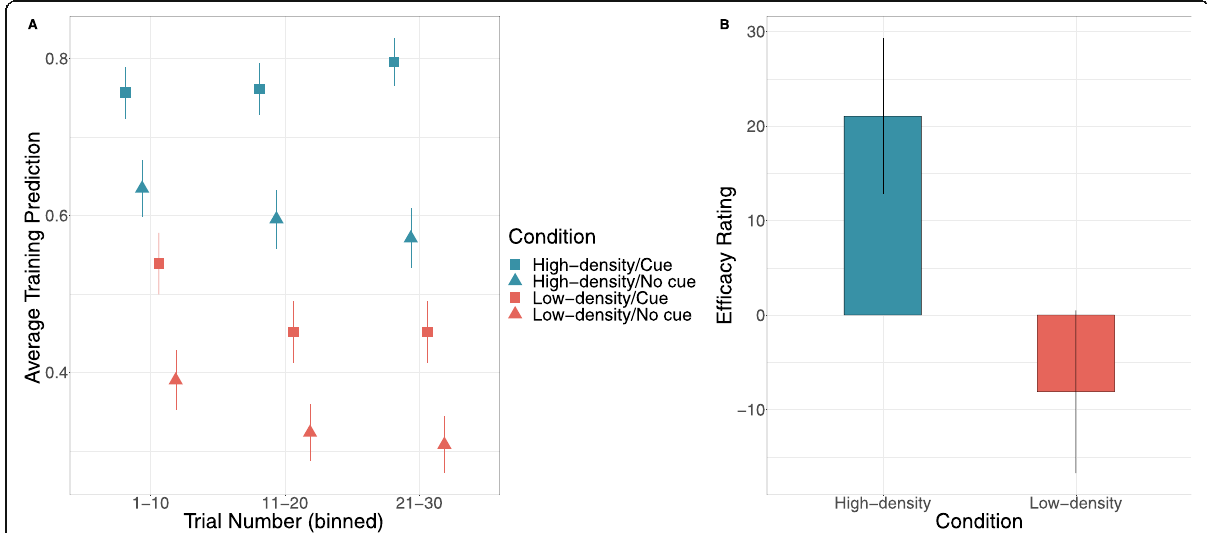
Fig. 3 Results from Experiment 1 for a training predictions as a function of outcome density condition, cue presence, and trial as well as b efficacy ratings as a function of outcome density condition. Error bars represent +1 standard error of the